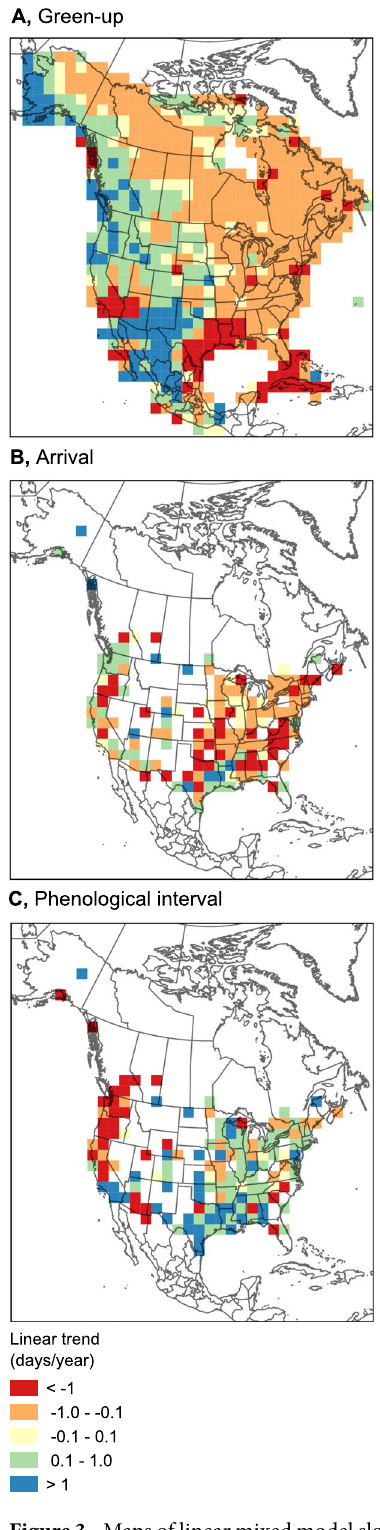
Figure 3. Maps of linear mixed model slopes in ( A ) green-up, ( B ) bird arrival, and ( C ) phenological interval between green-up and arrival for the period 2001–2012. Warmer colours indicate green-up ( A ) or arrival ( B ) getting earlier, or increasing negative phenological interval ( C ). Cooler colours indicate green-up or arrival getting later, or increasing positive phenological interval. Slopes for b and c are slopes across all species. Maps created with QGIS 2.6,